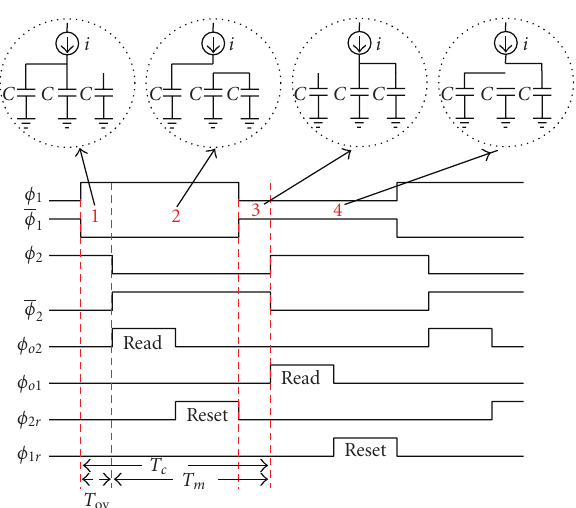
Figure 14: Operation of the interleaved overlapping windowed integration and the related clocks.